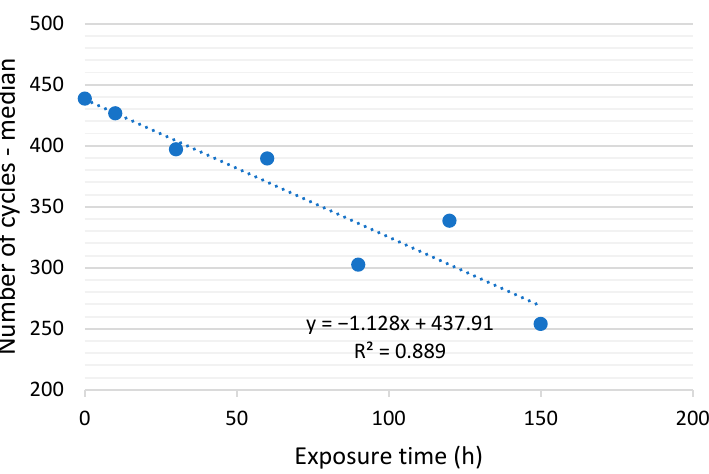
y = −1.128x + 437.91 R² = 0.889